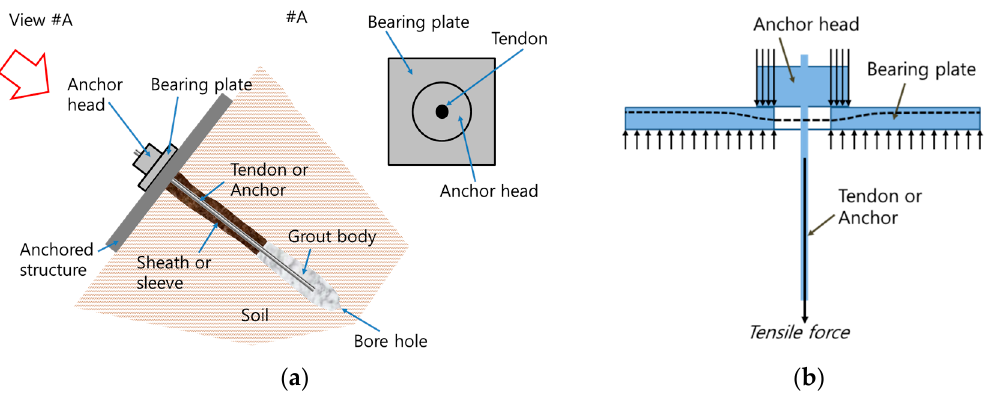
Figure 1. Conceptual diagram ( a ), and load state ( b ) of ground anchor system.